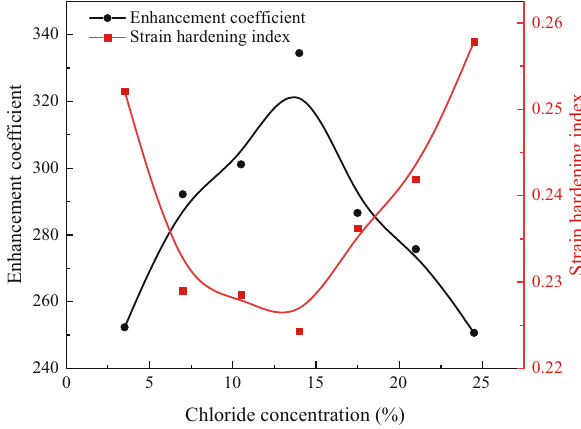
Figure 6: The strengthening coe ffi cient and strain hardening expo - nent of samples in di ff erent concentrations of